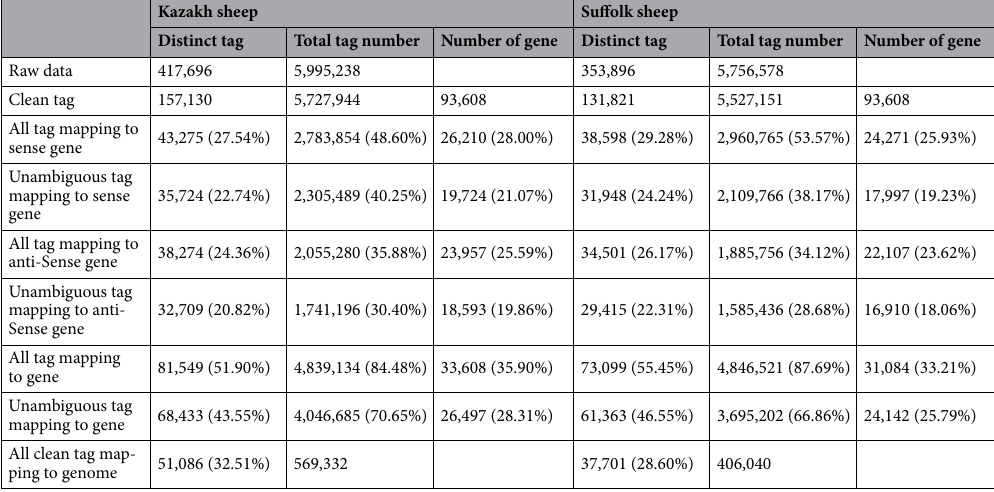
Table 2. Summary of the sequencing tags alignment to the reference genes and genome.